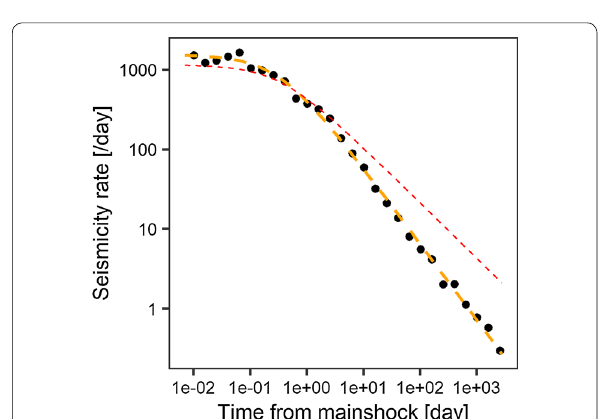
Fig. 6 Evolution of the seismicity rates after the 2011 Tohoku Earthquake. The thick orange dashed line represents the best fit based on Eq. (2) with p s = 0.95 , whereas the thin red dashed line shows a (failed) prediction with the same p -value as the case for the horizontal ground displacement rates ( p d )